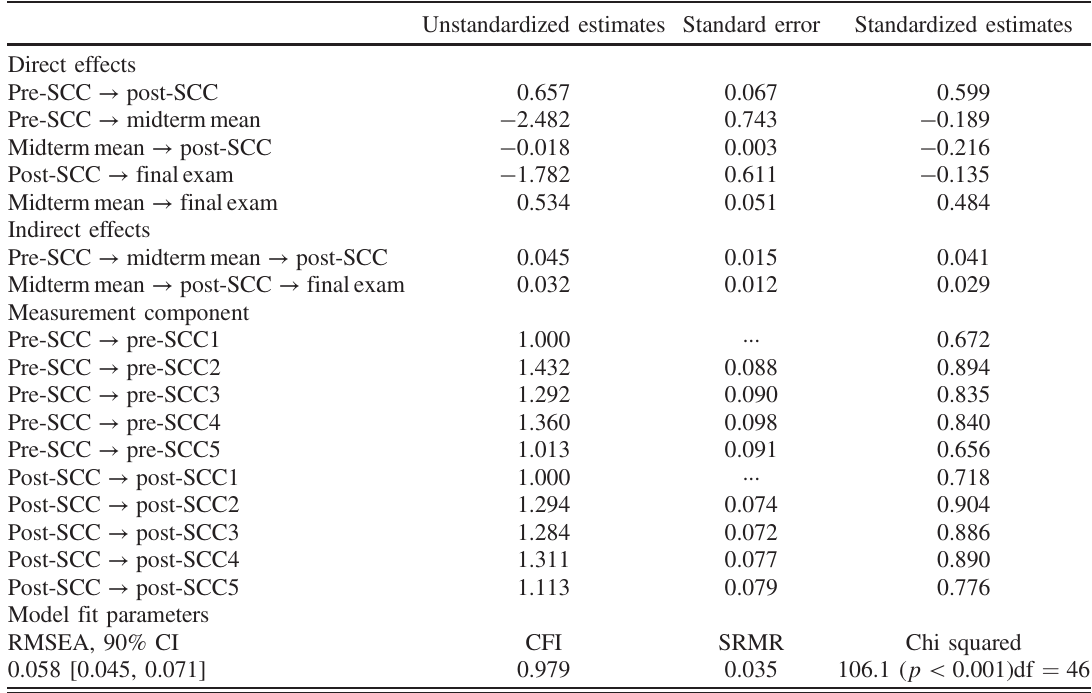
TABLE VII. SEM estimates of path coefficients. Standardized estimates are standardized for all